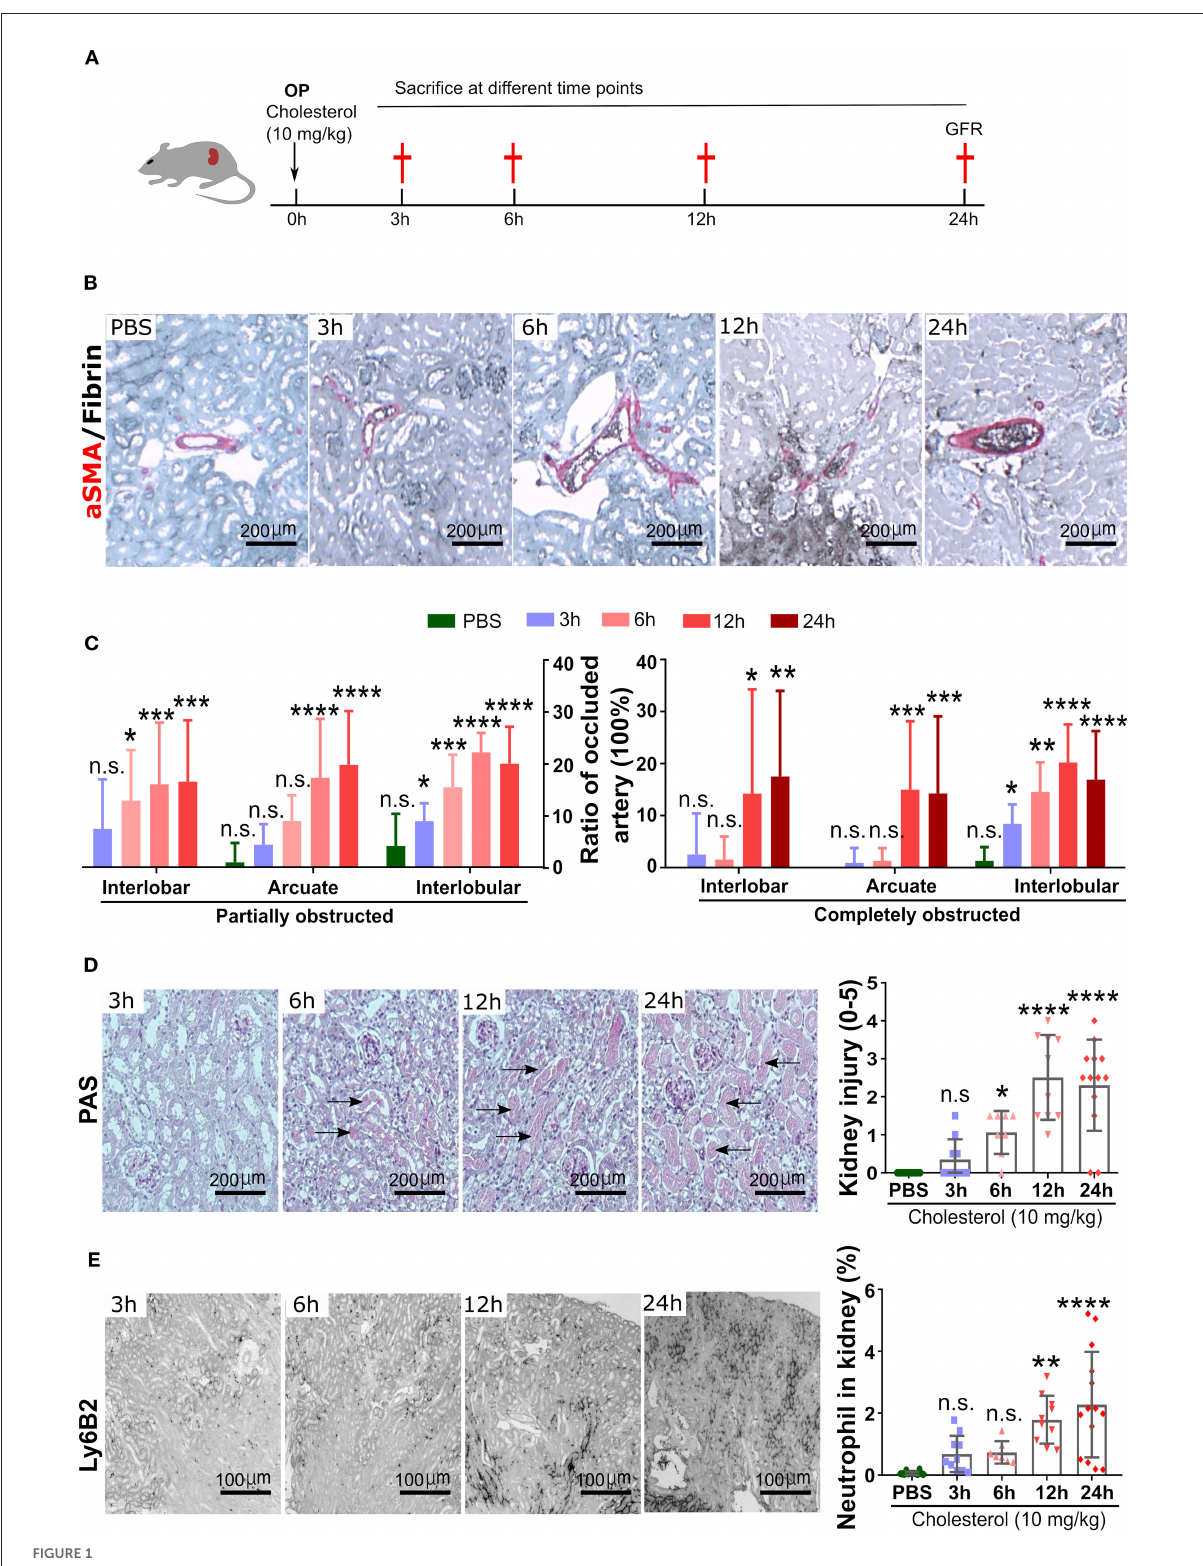
FIGURE1 Time kinetics of crystal clots formation and growth. (A) Schematic of experiment. (B) Representative images of aSMA/Fibrin staining at 3, 6, 12, and 24h post CC injection and PBS control. (C) Partially and completely obstructed arteries in the kidney 24h post-CC injection ( n = 8–12 mice/group). (D) Representative images of PAS staining at 3, 6, 12, and 24h post-CC injection, and kidney injury score ( n = 8–12 mice/group). (E) Representative images of Ly6B2 + staining at 3, 6, 12, and 24h post-CC injection, and neutrophils percentage in the kidney ( n = 8–14 mice/group). Data are means ± SD . One-way ANOVA. * P < 0.05; ** P < 0.01; *** P < 0.001. **** P <